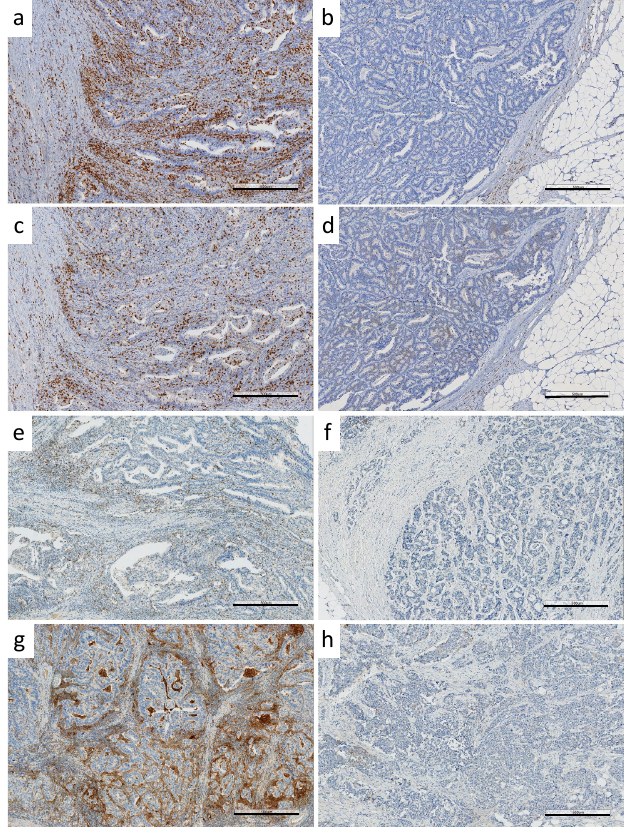
Figure 2. IHC staining of immunoproteins. Examples of ( a ) CD3 high, ( b ) CD3 low, ( c ) CD8 high, ( d ) CD8 low, ( e ) PDCD1 high, ( f ) PDCD1 low, ( g ) CD274 (IC) high and ( h ) CD274 (IC) low expressions. Black bars in the right bottom corners indicate the size of 500 µm.